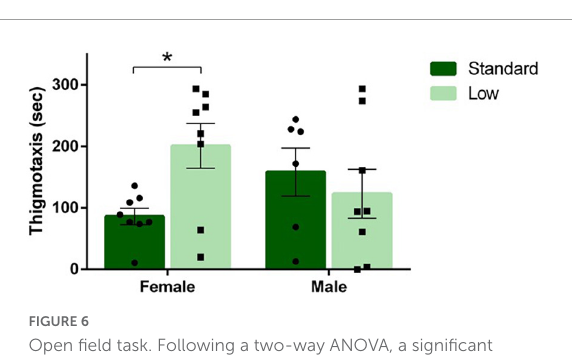
FIGURE6 Open field task. Following a two-way ANOVA, a significant interaction of sex and resources was observed for duration of thigmotaxis behavior in the open field task, where females raised in a low resource environment exhibited thigmotaxis longer than females raised in a standard resource environment (* p = 0.035). Individual data points overlay bars showing means ± SEM ( n = 8 for SR Females, SR Males, and LR females; n = 6 for LR